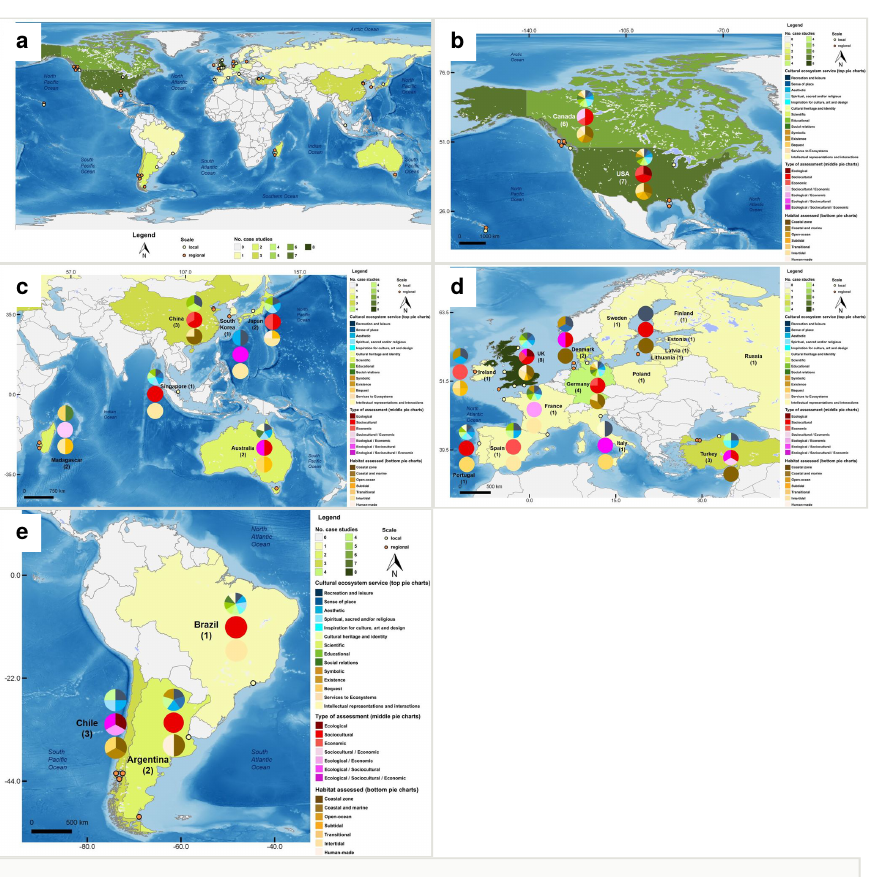
Figure 8. Geographical location of marine and coastal CES assessments. All case studies are included (n=60) and are divided by location: (a) World (overview); (b) North America; (c) Asia and Oceania; (d) Europe; and (e) South America. The maps depict the number of case studies per country (number under the name of the country), their spatial scale, marine and coastal CES classes assessed (top pie charts), type of assessments (middle pie charts), and type of habitats assessed (bottom pie charts). Assessments at the national or larger spatial scales are not represented in the fi gure. Dots connected with a black circle represent assessments undertaken in the same location. We used vector map data from Natural Earth, and raster map data from the General Bathymetric Chart of the Oceans